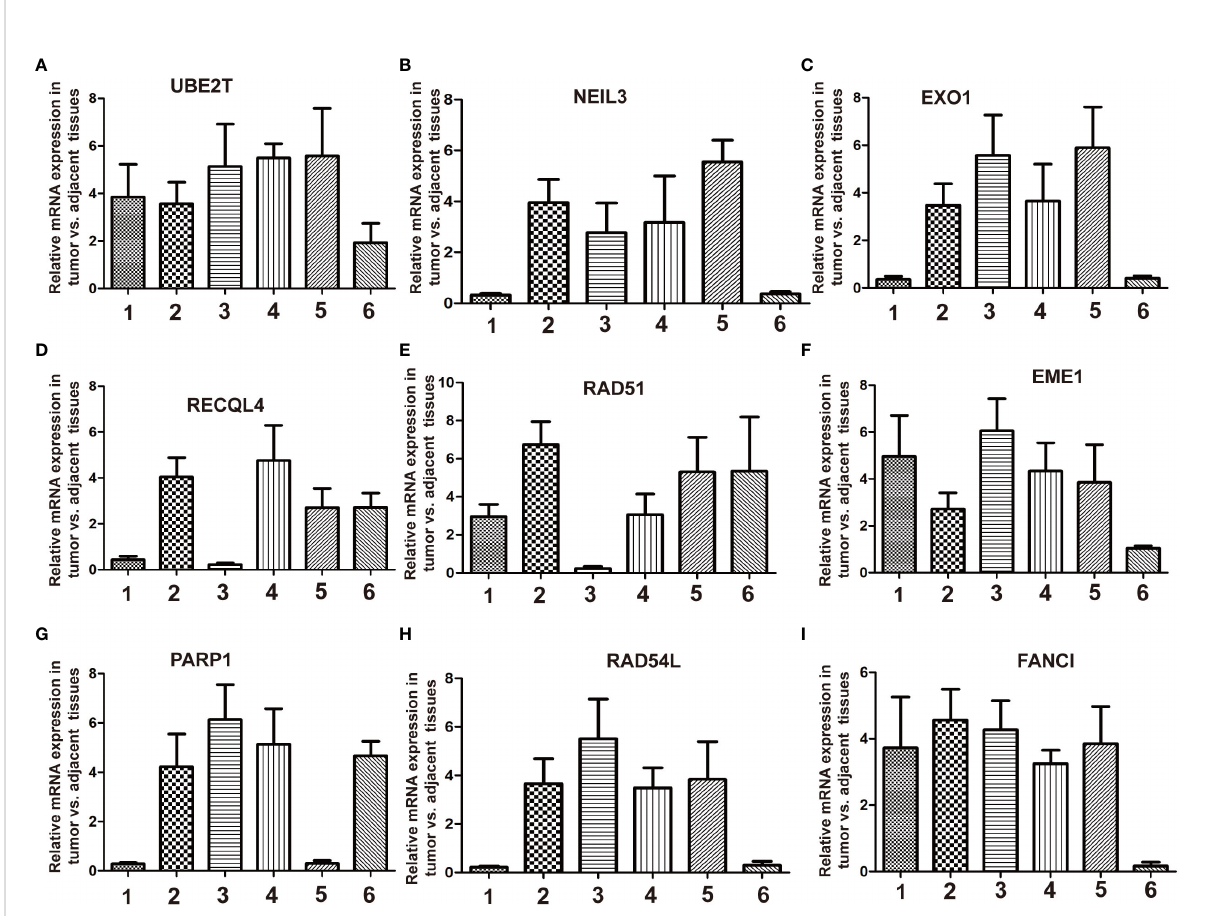
FIGURE 7 RT-qPCR validation of the relative expression level of DEGs between breast cancer and adjacent normal tissues. Total RNA is isolated from six pairs of clinical breast cancer and adjacent normal tissues. Relative mRNA expression was analyzed by qPCR. (A) UBE2T , (B) NEIL3 , (C) EXO1 , (D) RECQL4 , (E) RAD51 , (F) EME1 , (G) PARP1 , (H) RAD54L , and (I) FANCI